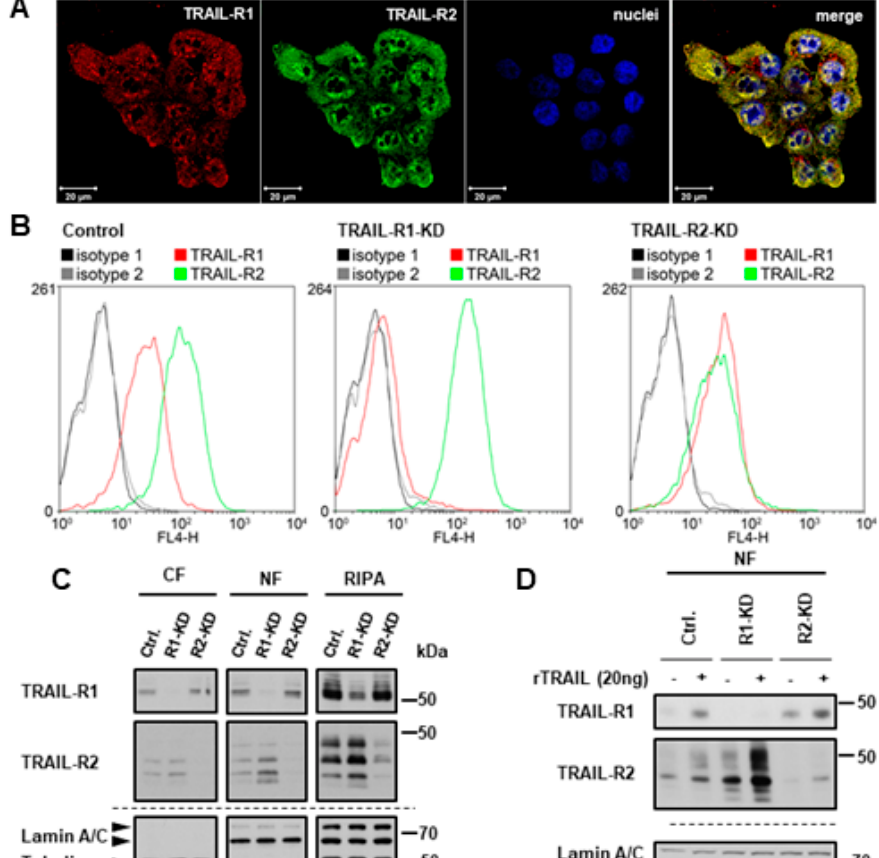
Figure 5. Impact of the interplay of TRAIL death receptors on their nuclear translocation. ( A ) Co-localization of TRAIL-R1 and TRAIL-R2 was analyzed by indirect immunofluorescence and confocal LSM in wild type PancTu-I cells. ( B – D ) The expression of TRAIL-R1 and TRAIL-R2 was downregulated in PancTu-I cells by stable transfection with receptor-specific shRNA. ( B ) For analysis of the cell surface levels of TRAIL-R1 and TRAIL-R2 cells were stained with APC-conjugated receptor-specific antibodies and the stainings measured by flow cytometry. Corresponding APC-conjugated isotype controls were used to validate staining specificity. Shown are representative histograms. ( C ) Intracellular distribution of the receptors was studied by Western blot in cytoplasmic fractions (CF), nuclear fractions (NF), and whole cell lysate (RIPA). Detection of β -tubulin (CF marker) and Lamin A / C (NF marker) were used as gel loading control. ( D ) Tracking of biotin-labeled cell surface receptors in the nuclear fractions of cells stimulated for one hour with recombinant TRAIL (rTRAIL) was studied in Western blotting. Protein lysates from nuclear fractions were immunoblotted for Lamin A / C (NF marker) as control for the equal amounts of extracts used for purification of